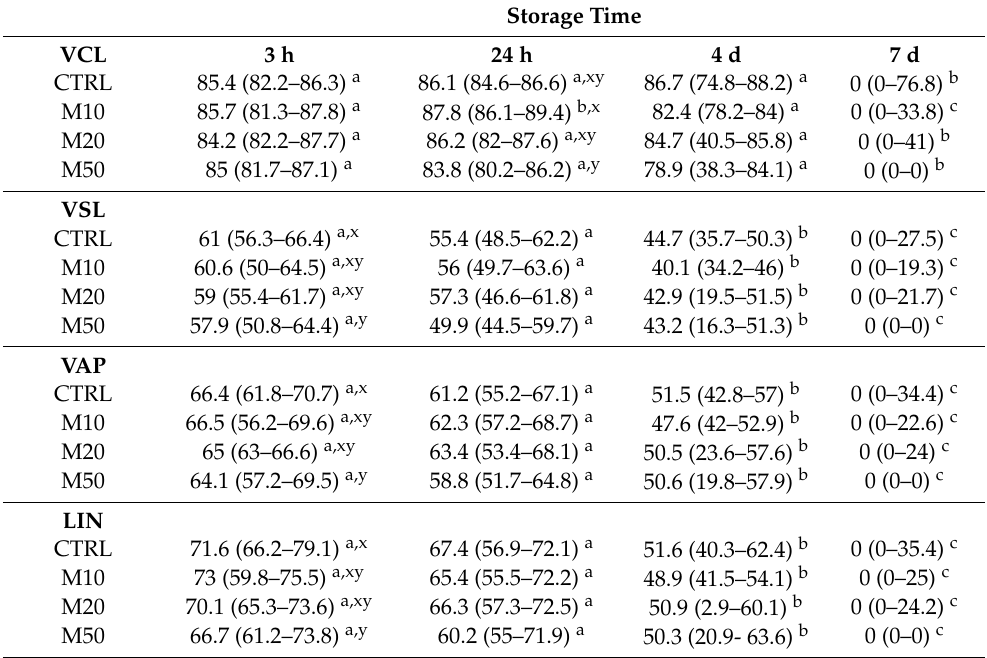
Table 3. Trends of semen kinetic parameters of canine ( n = 9) semen of control (CTRL) and semen extender Maca treatment groups (M10, M20 and M50) during storage at 4 ◦ C for 7 days. All values are expressed as median and interquartile range